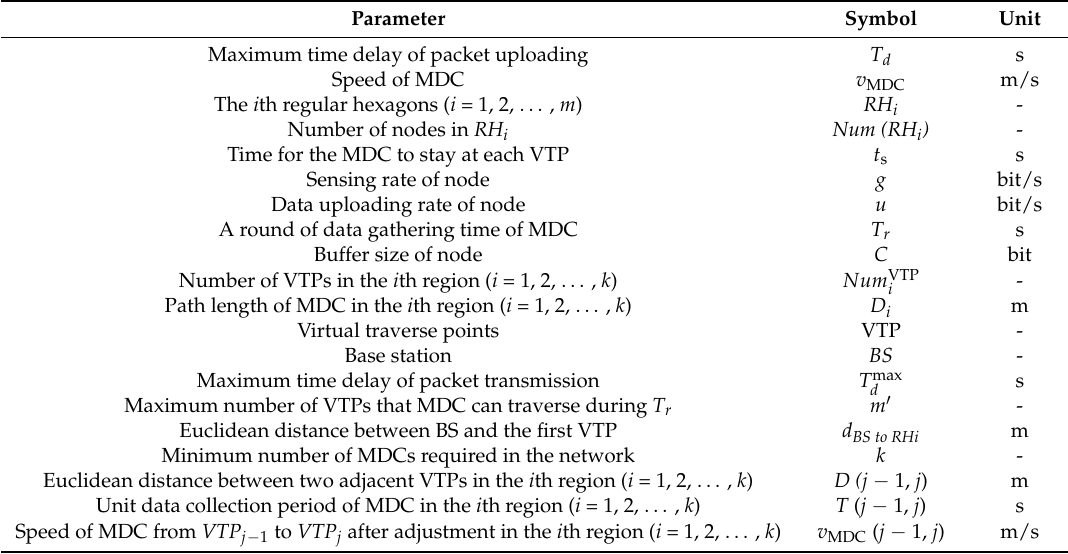
Table 2. Definitions of parameters in multi-MDCs-based data collection.